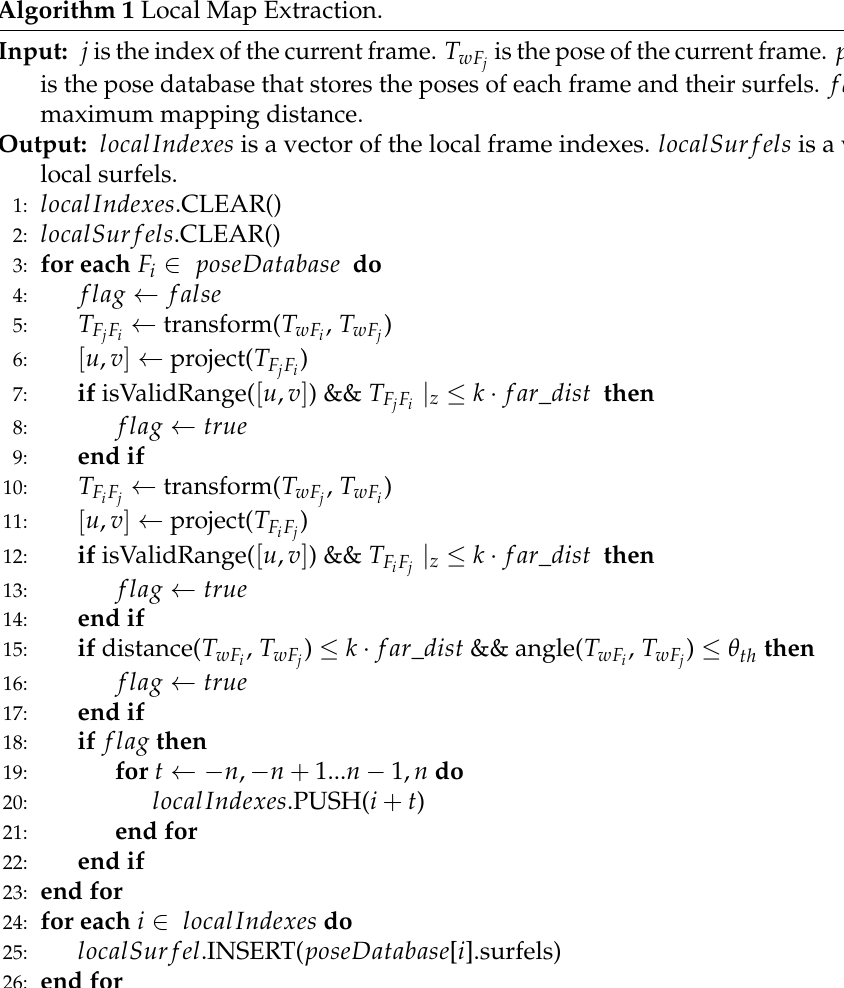
Algorithm 1 Local Map